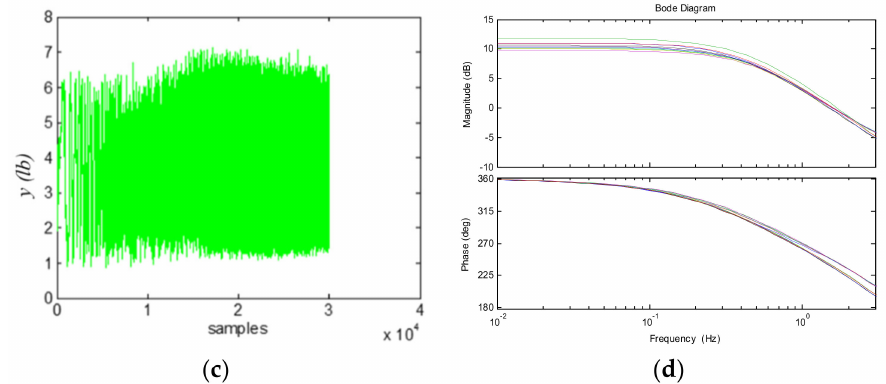
Figure A1. System identification. ( a ) input r ; ( b ) model input u ; ( c ) model output y ; ( d ) Bode